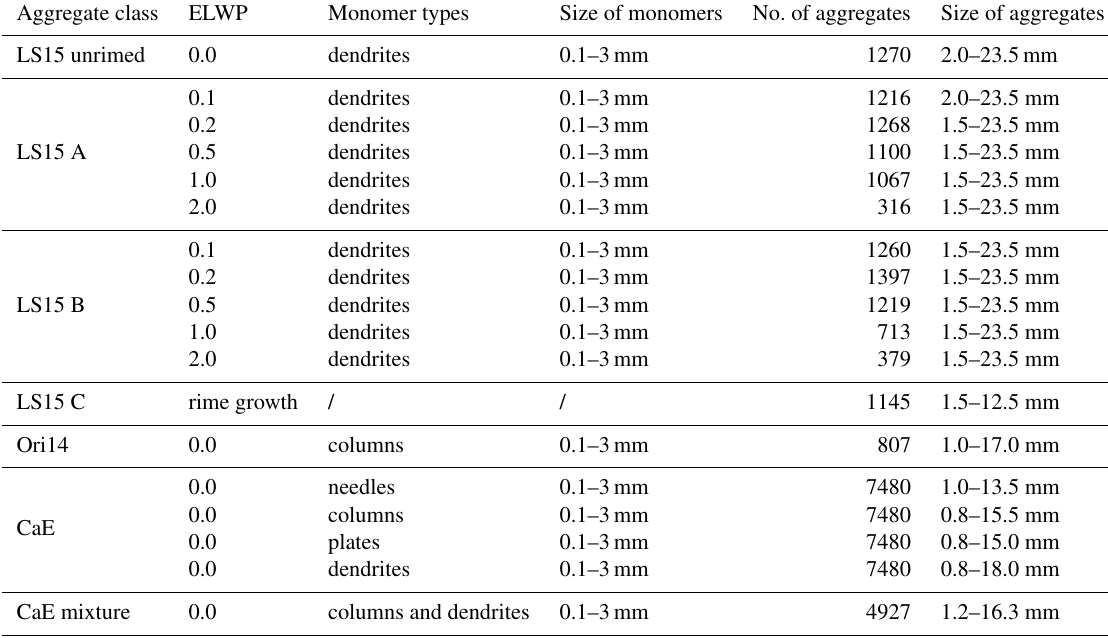
Table 1. Description of aggregates available in the snowScatt tool. For mD, AD, and vD relations see Fig. 4. Aggregate